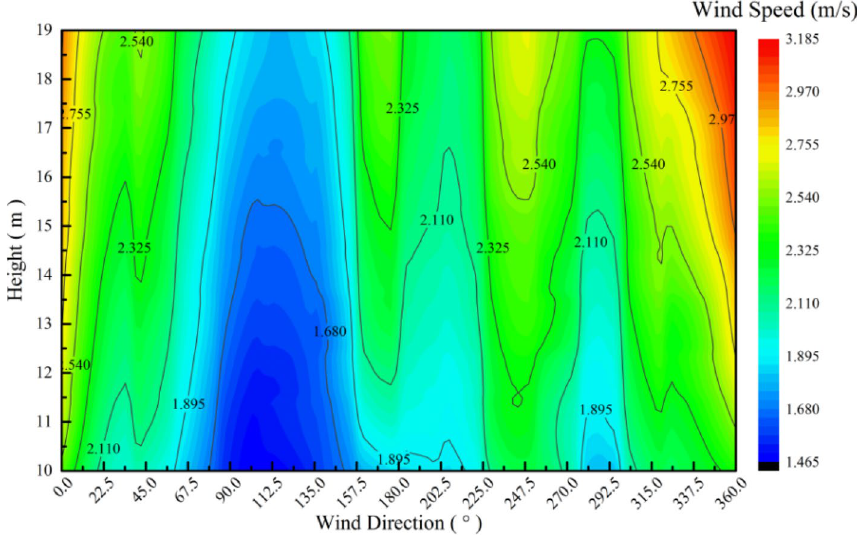
Figure 17. Annual wind speed distribution at all observed altitudes of 10–19 m.